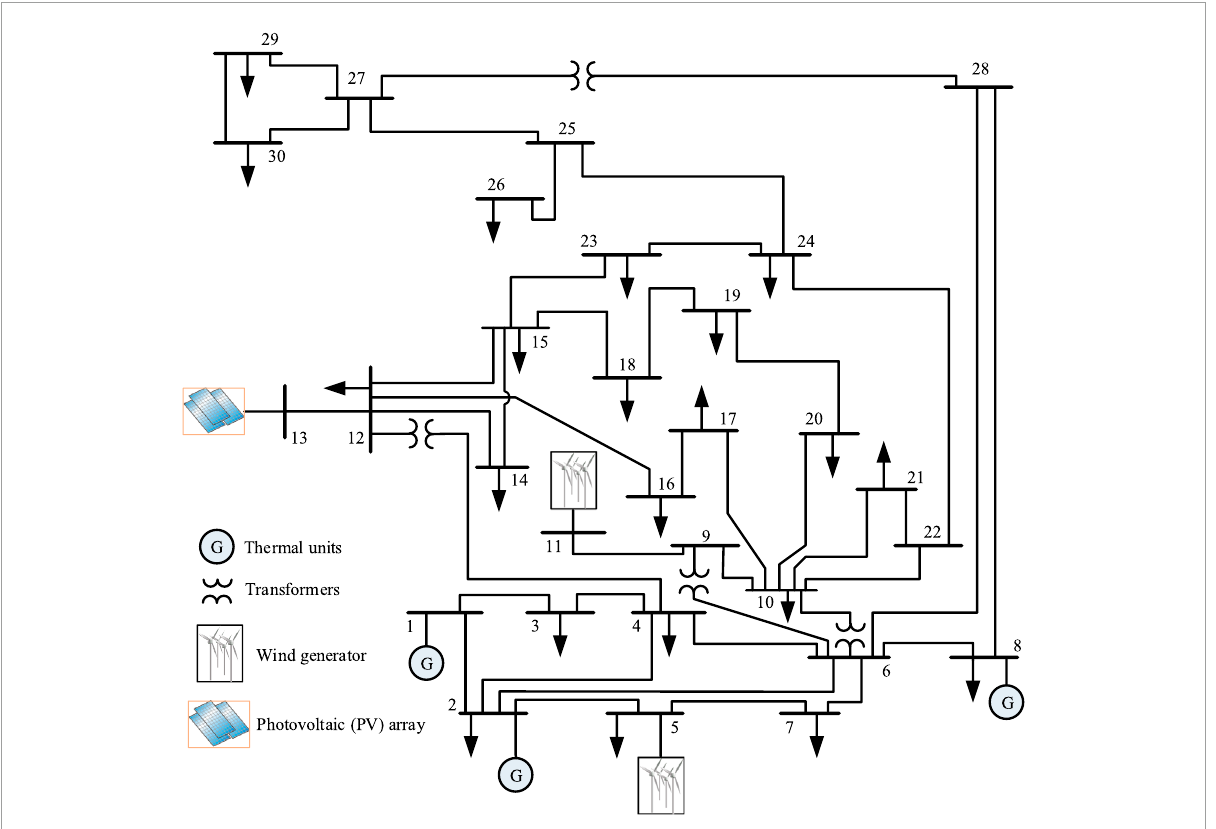
FIGURE 7 Single-line diagram of the IEEE 30-bus test system with wind and solar